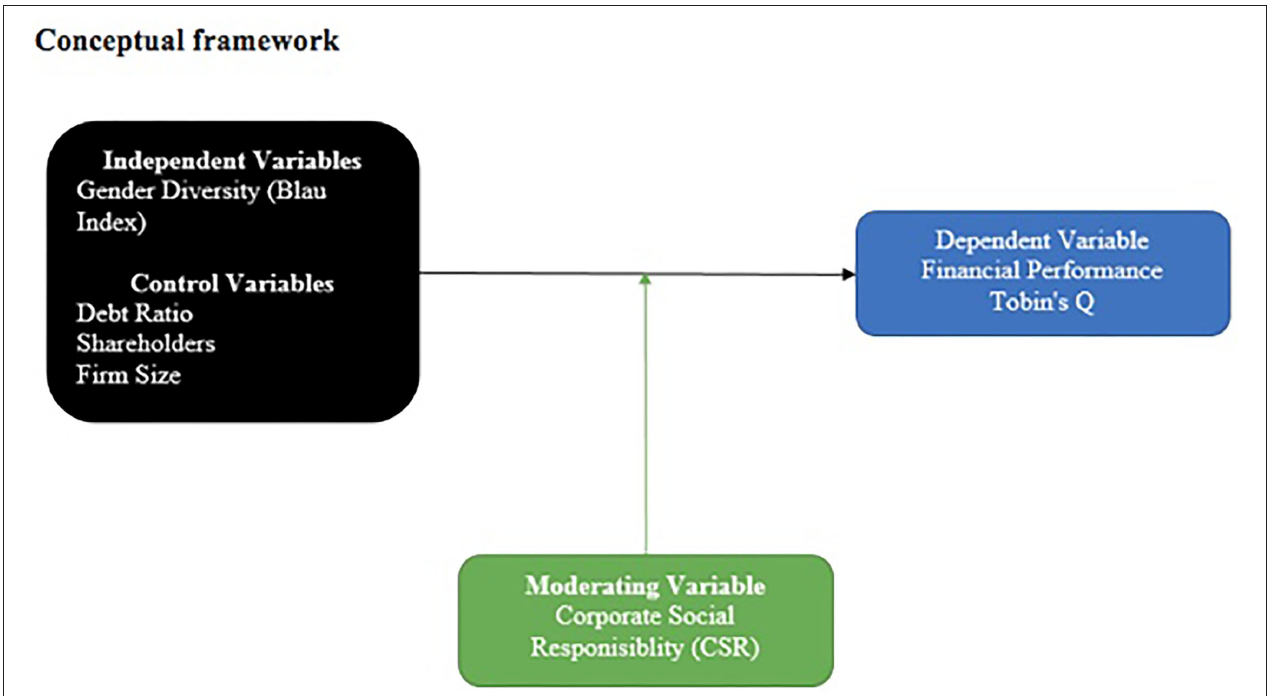
FIGURE 1 | Conceptual framework. Source: Researcher’s construction.